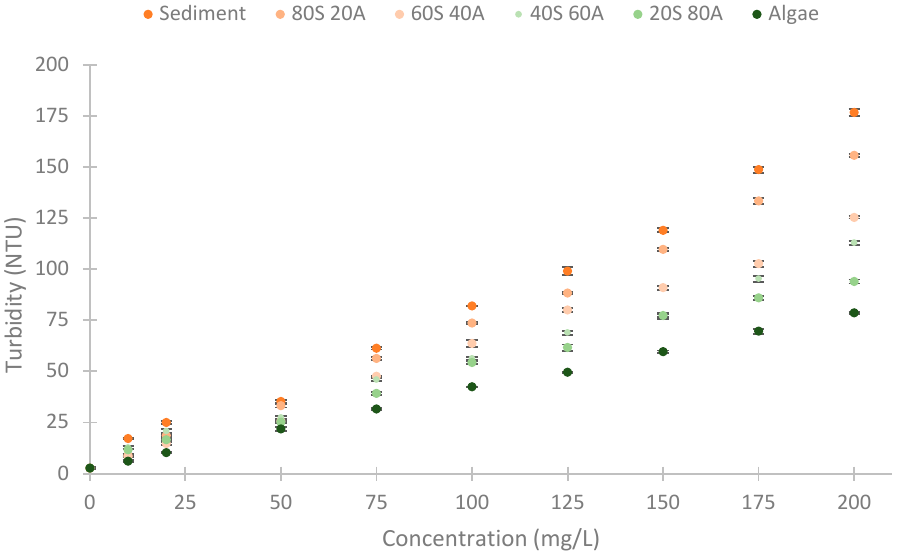
Figure 7. The turbidity of the different samples measured with a commercial turbidimeter.